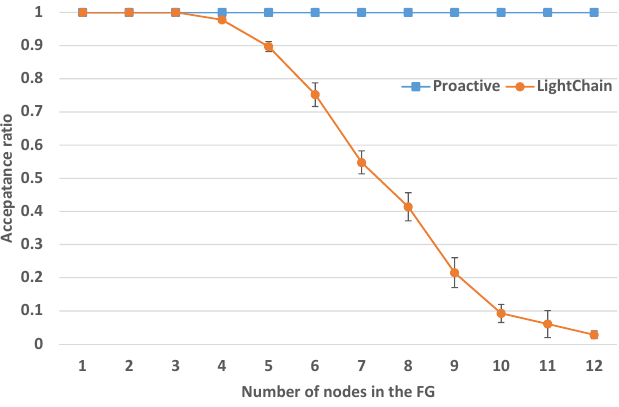
Figure 11. Acceptance ratio for increased FG